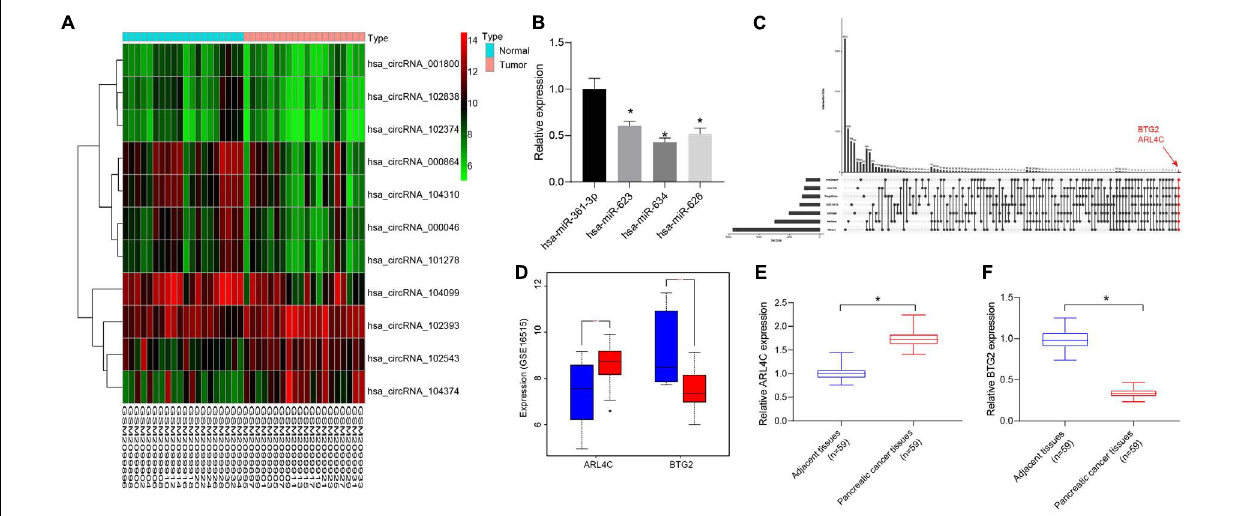
FIGURE 1 | CircRNA_000864 may affect pancreatic cancer development by mediating B-cell translocation gene 2 (BTG2) through miR-361-3p. (A) Heatmap of 10 differentially expressed circular RNAs (circRNAs) in pancreatic cancer circRNA gene expression dataset GSE79634. The abscissa indicates the sample number, the ordinate indicates the differentially expressed gene, and the right upper histogram is the color gradation. Each rectangle in the figure corresponds to one sample expression value. (B) Expression of miRNAs in pancreatic cancer tissues ( n = 59). (C) The comparison between the target gene predicting results of miR-361-3p in TargetScan, RNA22, miRWalk, miRSearch, starBase, and HOCTAR, and the results of differential analysis of GSE16515. The red dot-line indicates that there are two overlapped genes. (D) ARL4C and BTG2 expression in the GSE16515 gene expression datasets. Red indicates tumor tissue, and blue indicates normal tissue. (E) ARL4C BTG2 expression in pancreatic cancer tissues. (F) BTG2 expression in pancreatic cancer tissues. * p < 0.05 vs. adjacent normal tissues. The above data were all measurement data and expressed as mean ± standard deviation. The paired t -test was employed to compare data between two groups. One-way analysis of variance (ANOVA) was adopted for comparison among multiple